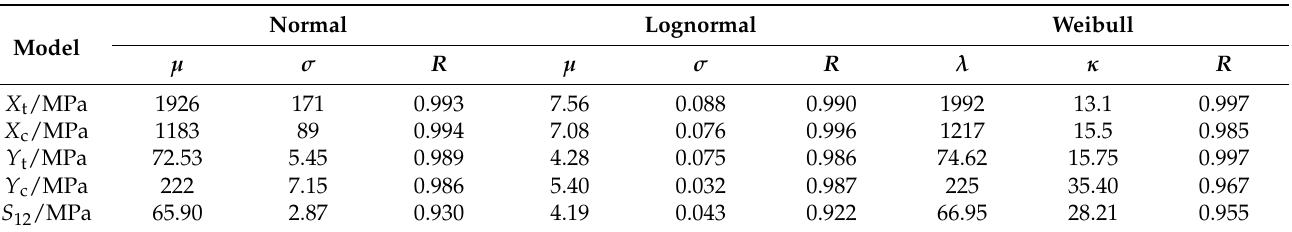
Table 8. Values of the three statistical distribution parameters for the strength properties of H-GFRPs at RT.